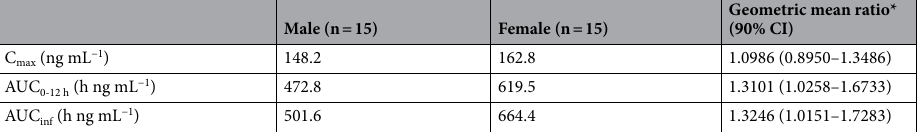
Table 3. Geometric mean ratio and 90% confidence interval of pharmacokinetic parameters of zolpidem between sexes. *Geometric mean ratio of females to males. C max maximum plasma concentration, AUC 0-12 h area under the concentration curve from 0 to 12 h, AUC inf area under the concentration curve from 0 to